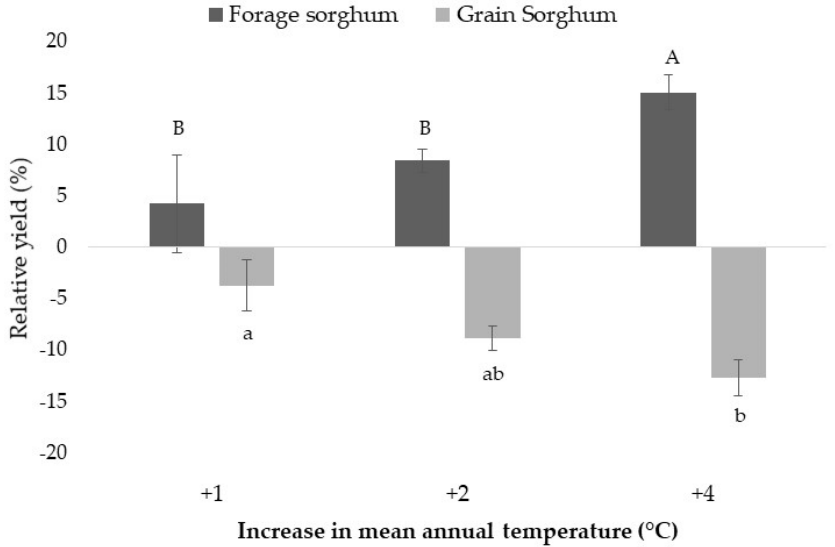
Figure 3. Relative yield of forage and grain sorghum exposed to increases in mean annual temperature, compared to the current yields. Current yields are 14.9 Mg ha − 1 and 9.3 Mg ha − 1 for forage and grain sorghum, respectively. Different capital or lowercase letters above error bars indicate significant differences ( p ≤ 0.05) among forage and grain sorghum treatments, respectively.